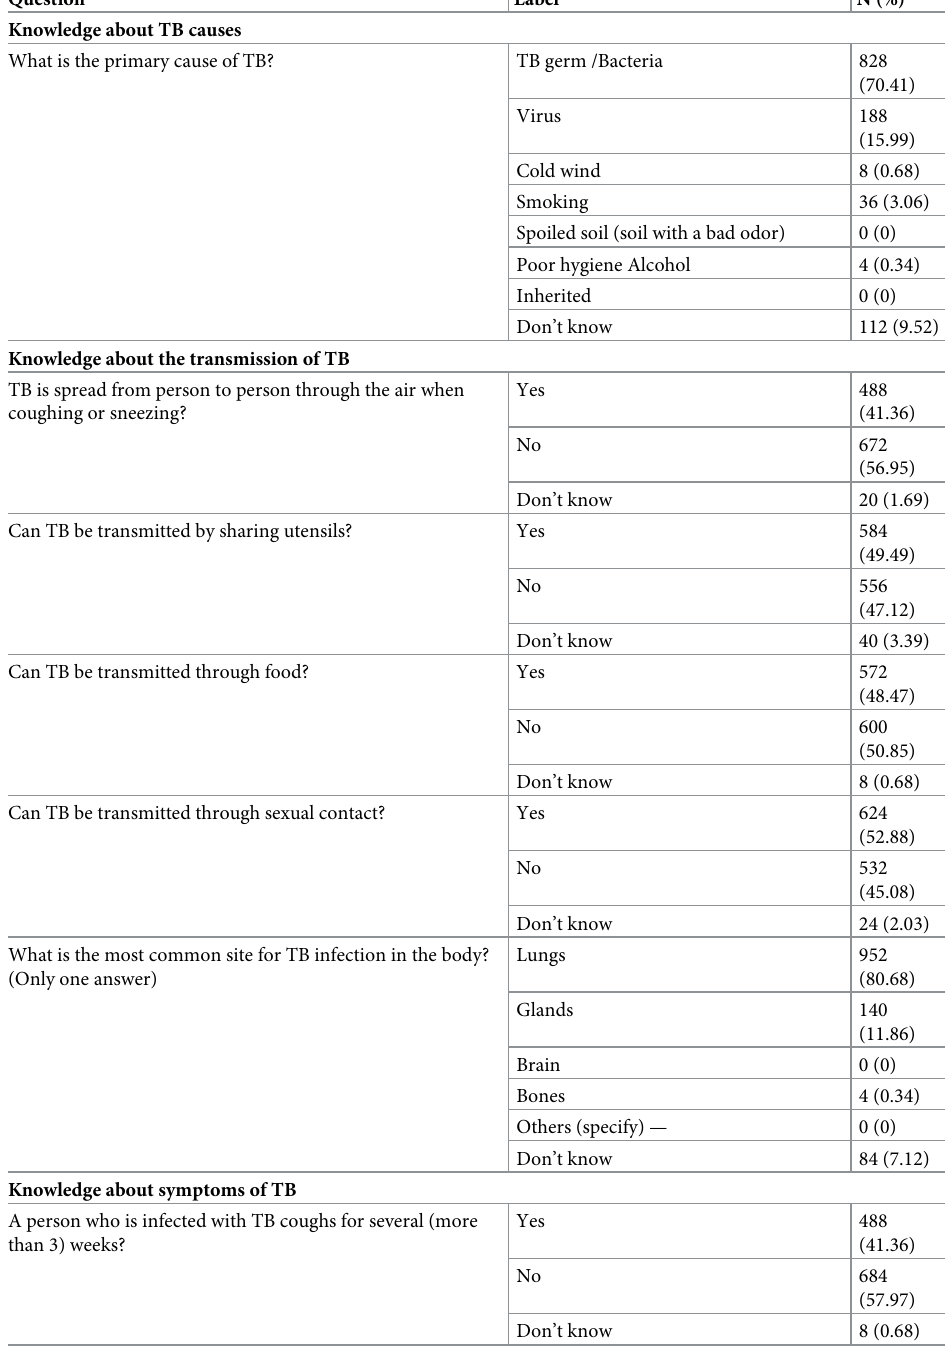
Table 2. Knowledge of respondents on TB cause, transmission, signs & symptoms, treatment, and attitudes and practices toward TB among